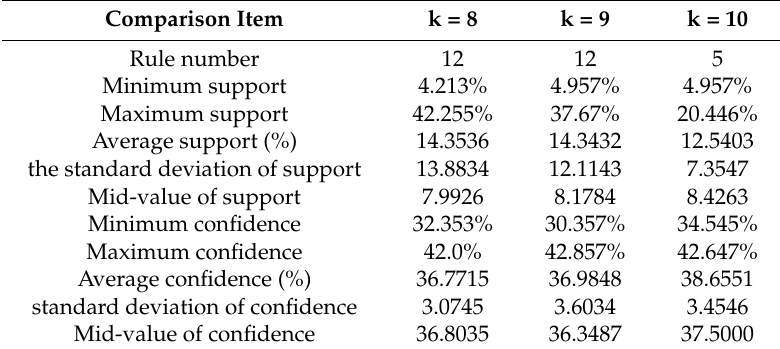
Table 6. Statistics comparison of association rules with different k values (the same data segment correspondence).